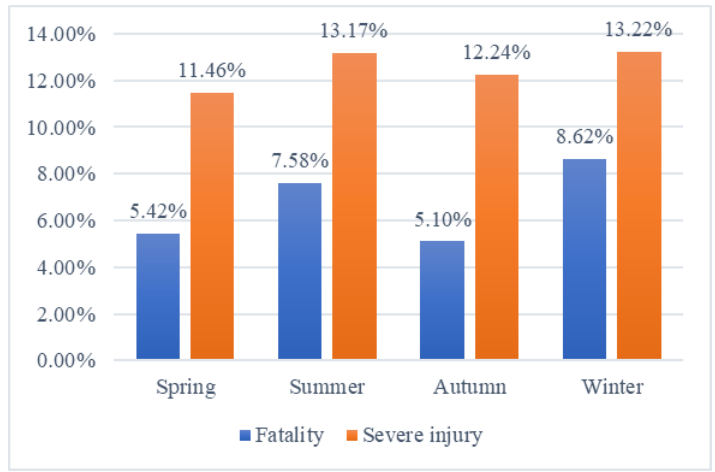
Figure 6. The proportion of fatal and severe injury of total number of Hazmat accidents by